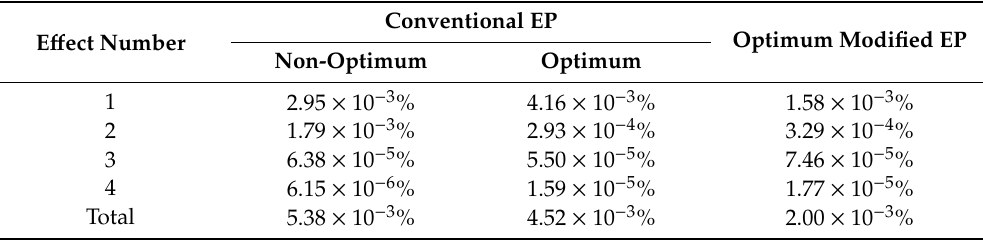
Table 2. Comparison of sucrose inversion losses in the non-optimum conventional evaporation process, the optimum conventional evaporation process, and the optimum modified evaporation